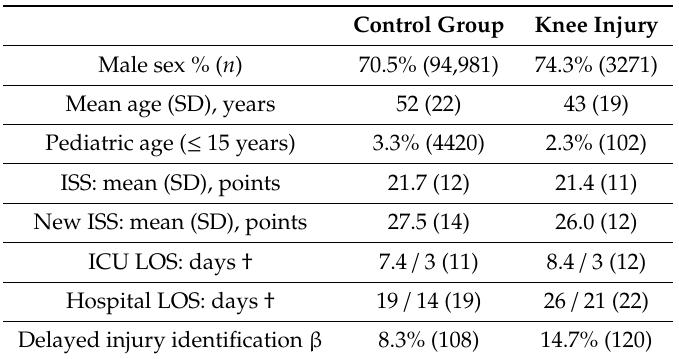
Table 2. Demographic and outcome